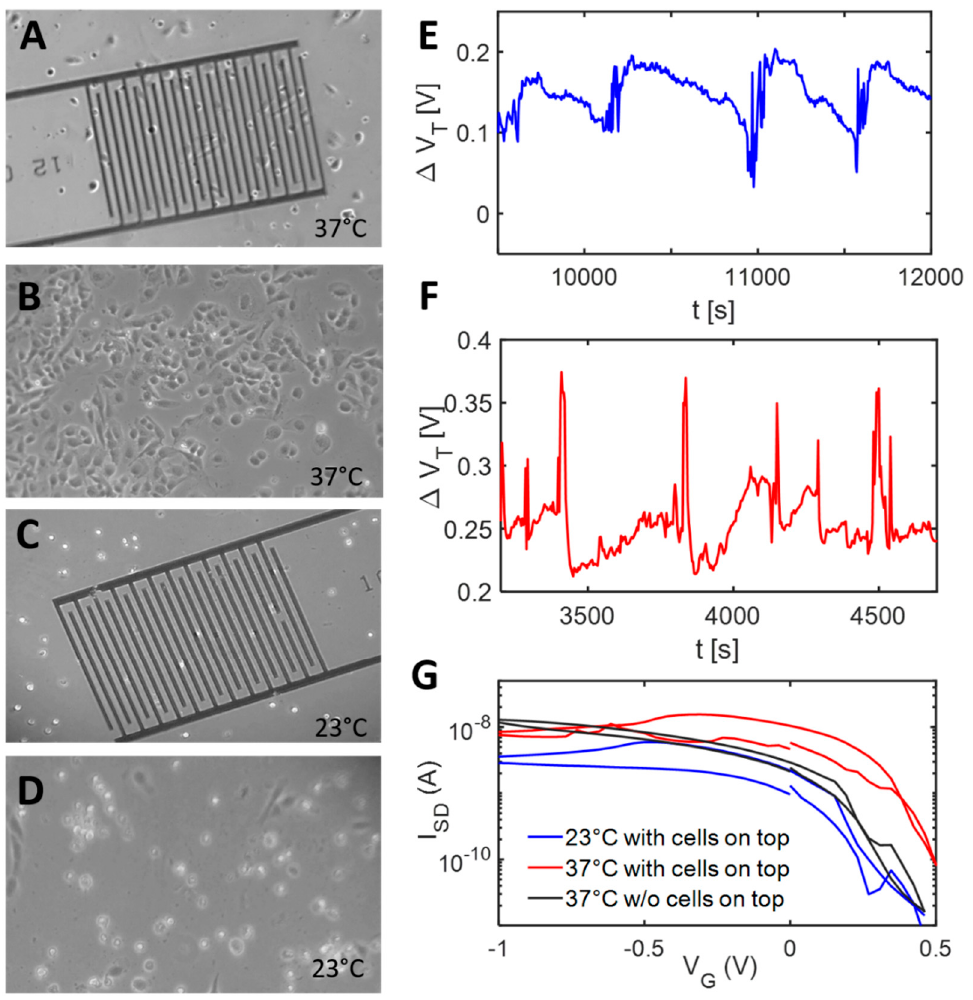
Figure 5. ( A – B ) Microscopy images of Saos-2 cells incubated at 37 °C on PNIPAAM-functionalized sensors ( A ) and planar reference substrates ( B ). A strong cell adhesion can be seen in both cases, indicating viable cells. ( C – D ) Microscopy images of Saos-2 cells at 23 °C on PNIPAAM-functionalized sensors ( C ) and planar reference substrates ( D ). Lowering the temperature to 23 °C results in detachment of the cells, as mainly spherical residues can be seen. E) - F) Real-time sensor response of PNIPAAM-coated FET at 23 °C ( E ) and 37 °C ( F ). In both cases, a periodically appearing signal can be seen when cells do come in contact with sensor surface. ( G ) Transfer characteristics of sensors with and without cells. (Data extracted from time points of panels E and F, where spikes are present.) If cells are present, the capacitive part of the curve is more pronounced. In contrast, there is only small hysteresis when no cells are present (black curve).